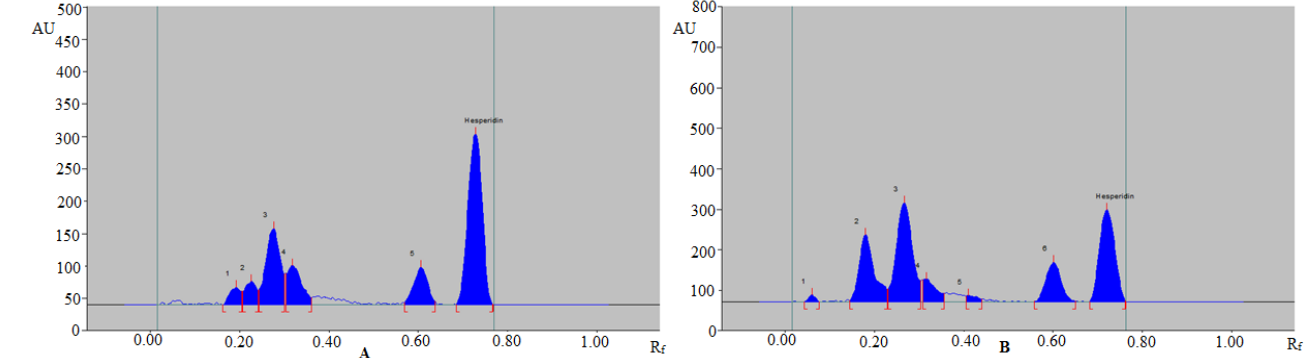
Figure 5. Spectrodensitograms of HSP in methanolic extract of ( A ) mosambi peels and ( B ) orange peels obtained using RP-HPTLC method.